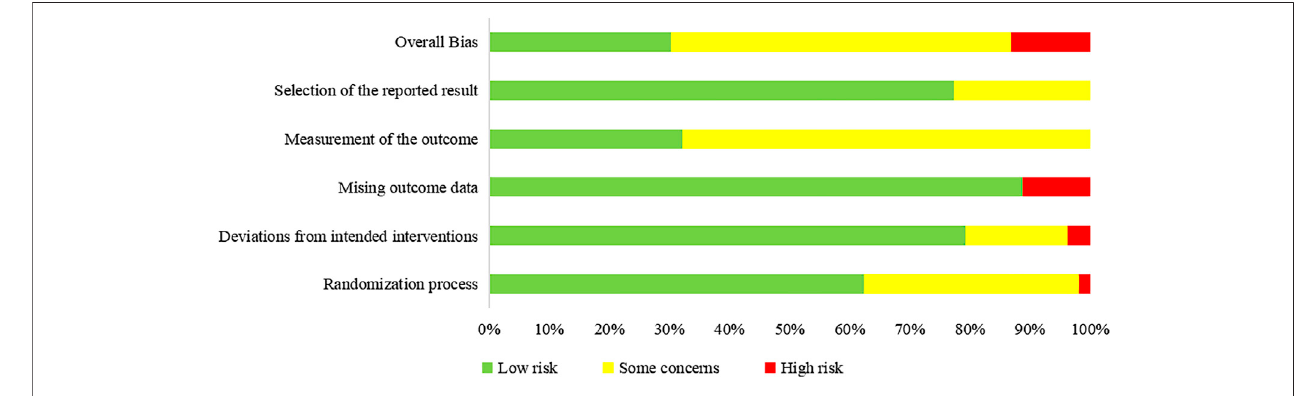
FIGURE 2 | Summary of risk of bias.